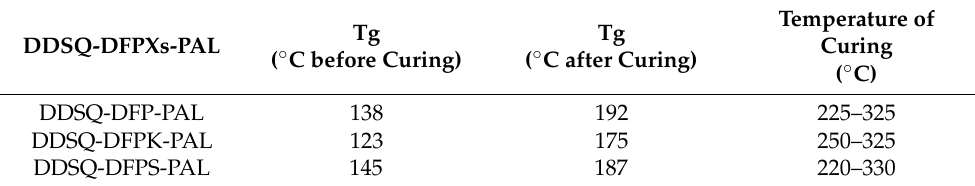
Table 1. DSC data of